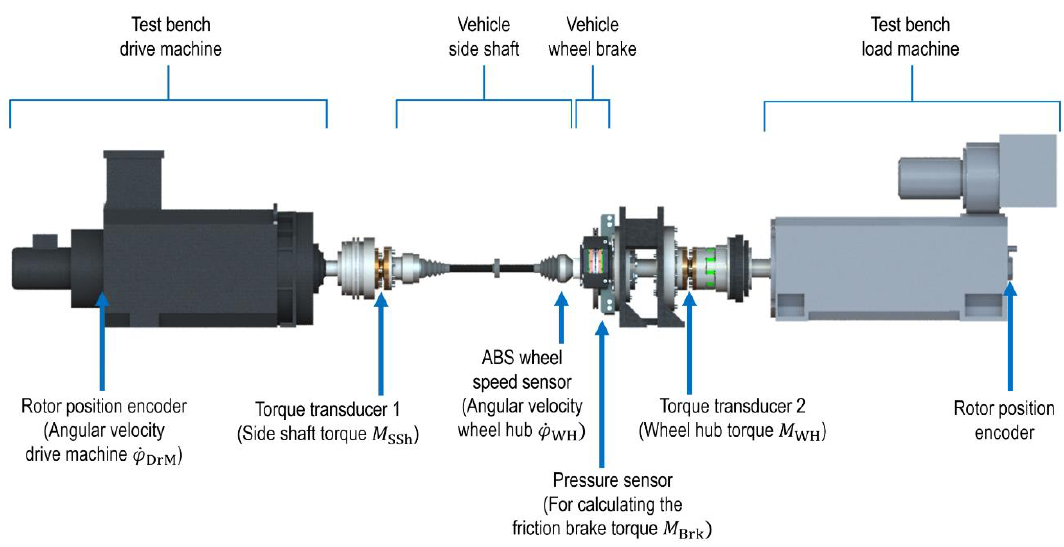
Figure 5. Positions of the relevant sensors of the applied HiL test bench and the relevant, corresponding measured values.